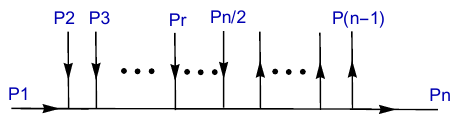
Figure 3 . Half Ladder Feynman